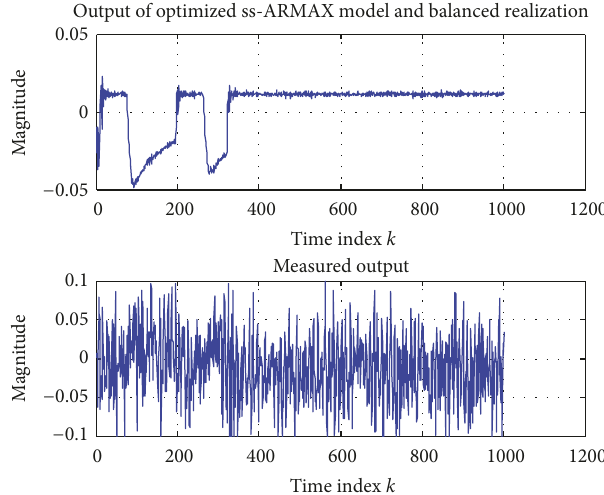
Figure 10: Simulated and measured output using optimized ARX (balanced realization) model at flow coefficient 0.51.